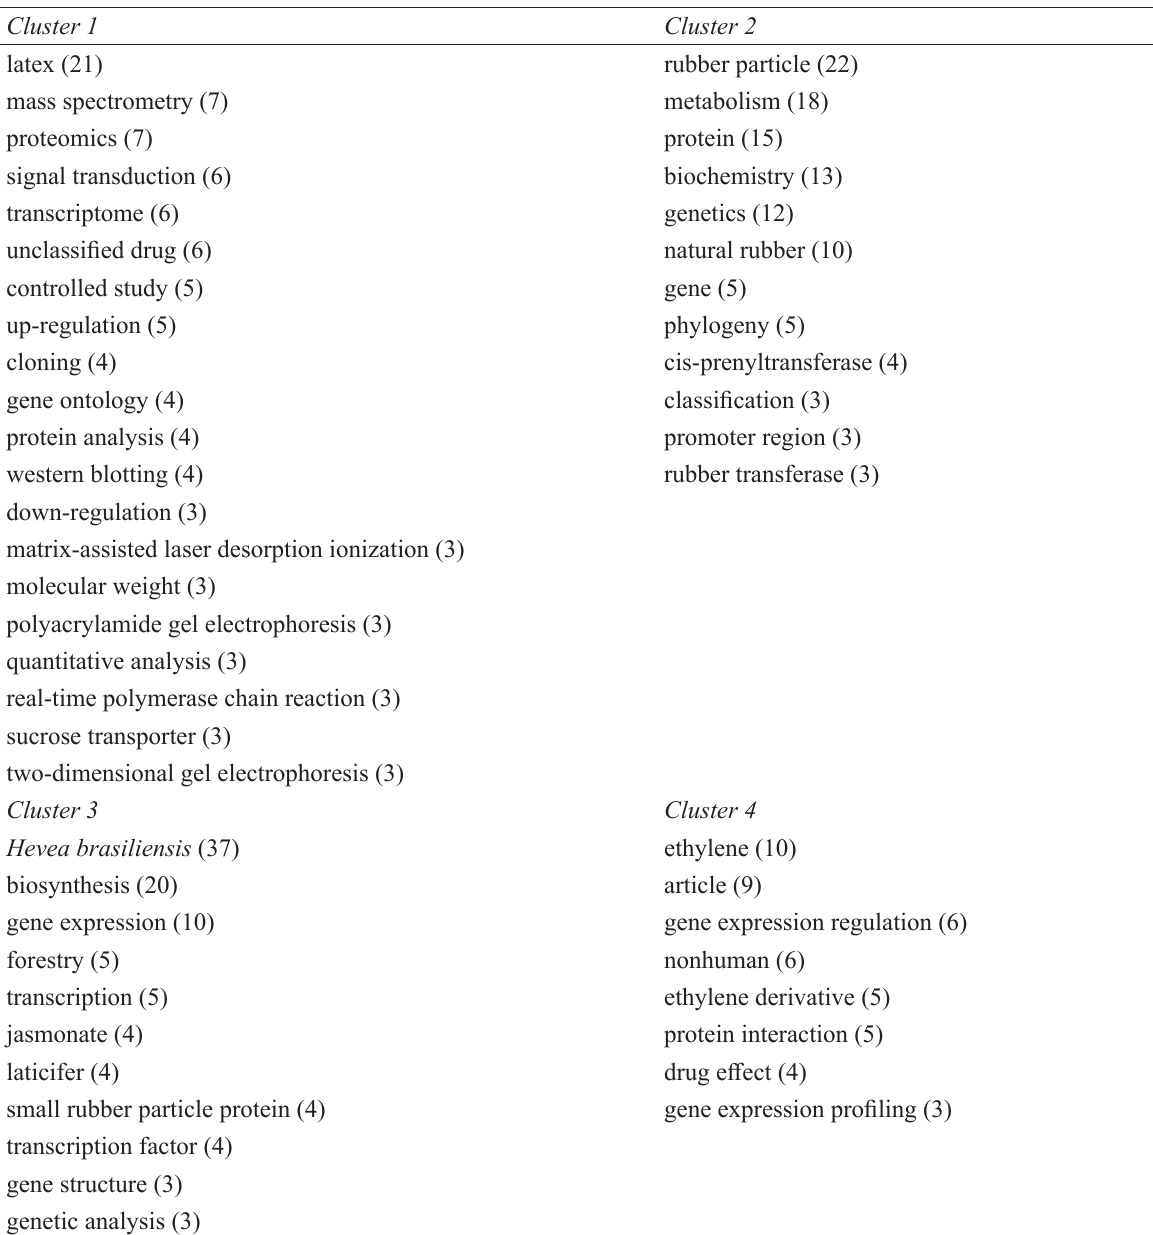
Table 2. Keyword clusters in research related to physiological mechanisms underlying latex production practice (n = 41). Data were derived from VOSviewer with three minimum occurrences. The number in brackets expresses the